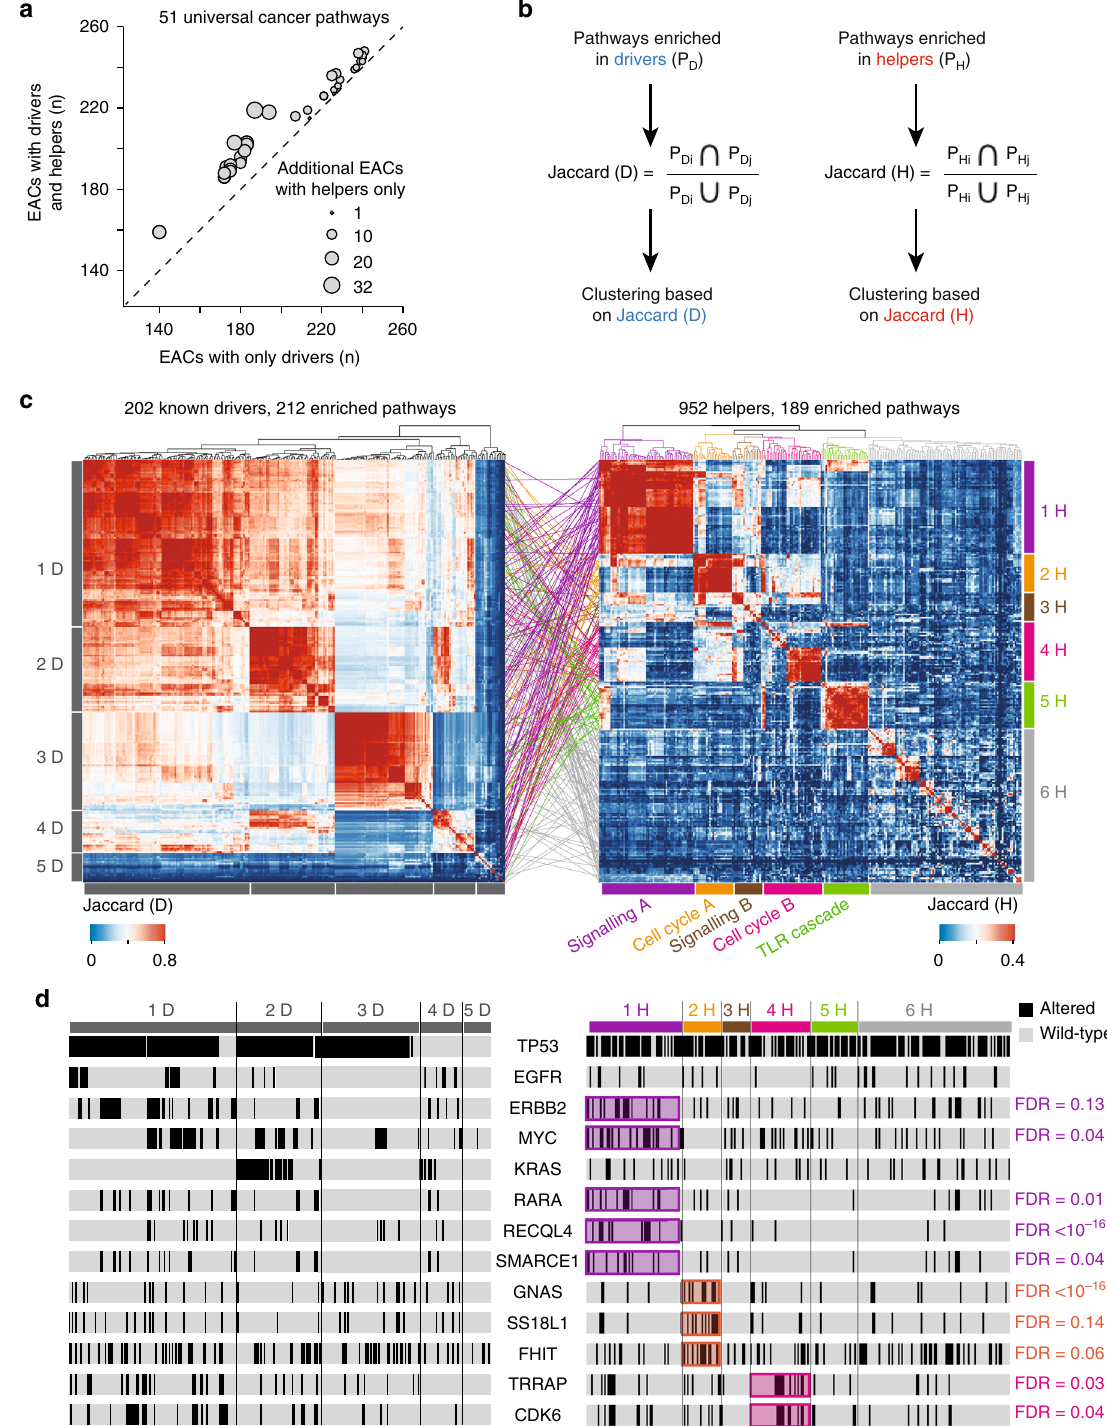
Fig. 2 Perturbed processes in 261 EACs. a Scatterplot of 51 universal pathways enriched in known drivers and helpers. For each pathway, the number of EACs with altered drivers and the number of EACs with altered drivers and helpers is shown. The size of dots is proportional to the additional EACs with perturbations in these pathways because of altered helpers only. b Schematic of the procedure to cluster EACs according to pathways enriched in known drivers or helpers. Enriched pathways are mapped to individual EACs and the Jaccard index is calculated as the proportion of shared pathways over the total pathways in each pair of samples ( i, j ). Hierarchical clustering is then performed. c Clustering of 261 EACs according to pathways enriched in known drivers and helpers. Five clusters were identi fi ed using known drivers (1D-5D) and six using helpers (1H-6H). Cluster-matching coloured lines show where EACs clustered by pathways enriched in helpers map in the driver clusters. d Mutational status of selected known drivers across 261 EACs. Drivers enriched in clusters of helpers are highlighted. Signi fi cance was assessed using the Fisher ’ s exact test, after correcting for False Discovery Rate